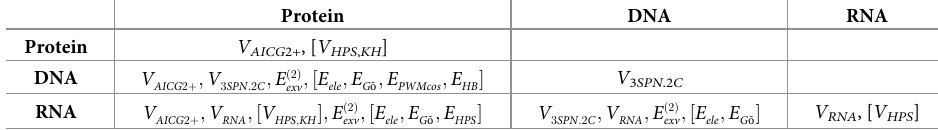
Table 1. Available CG models in heterogeneous biomolecular